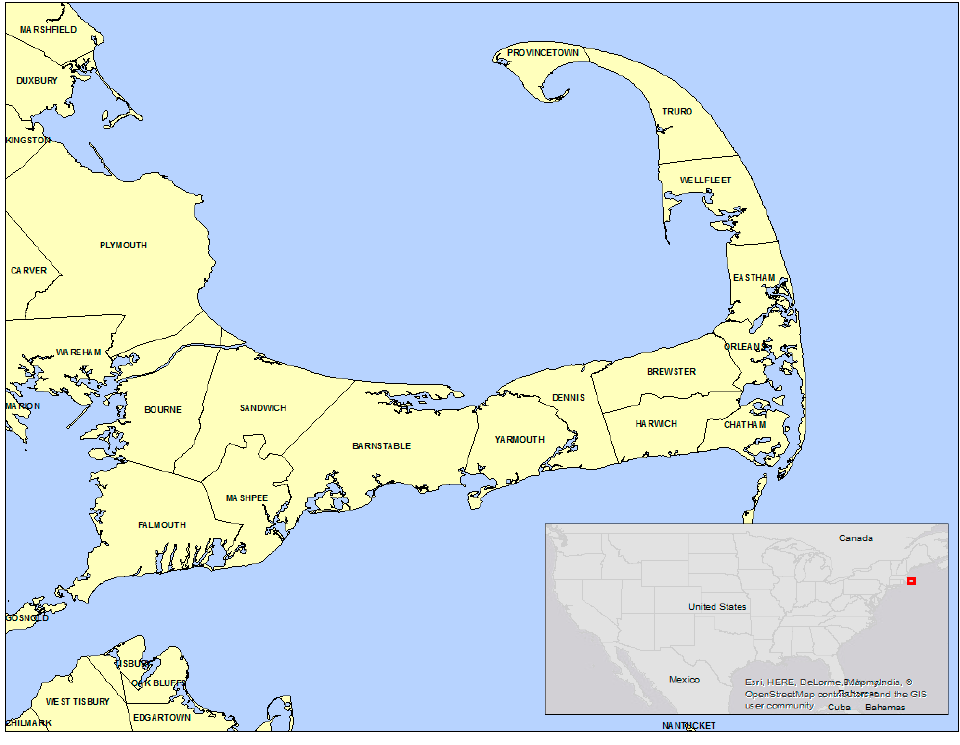
Figure 1. Cape Cod, Massachusetts, USA.